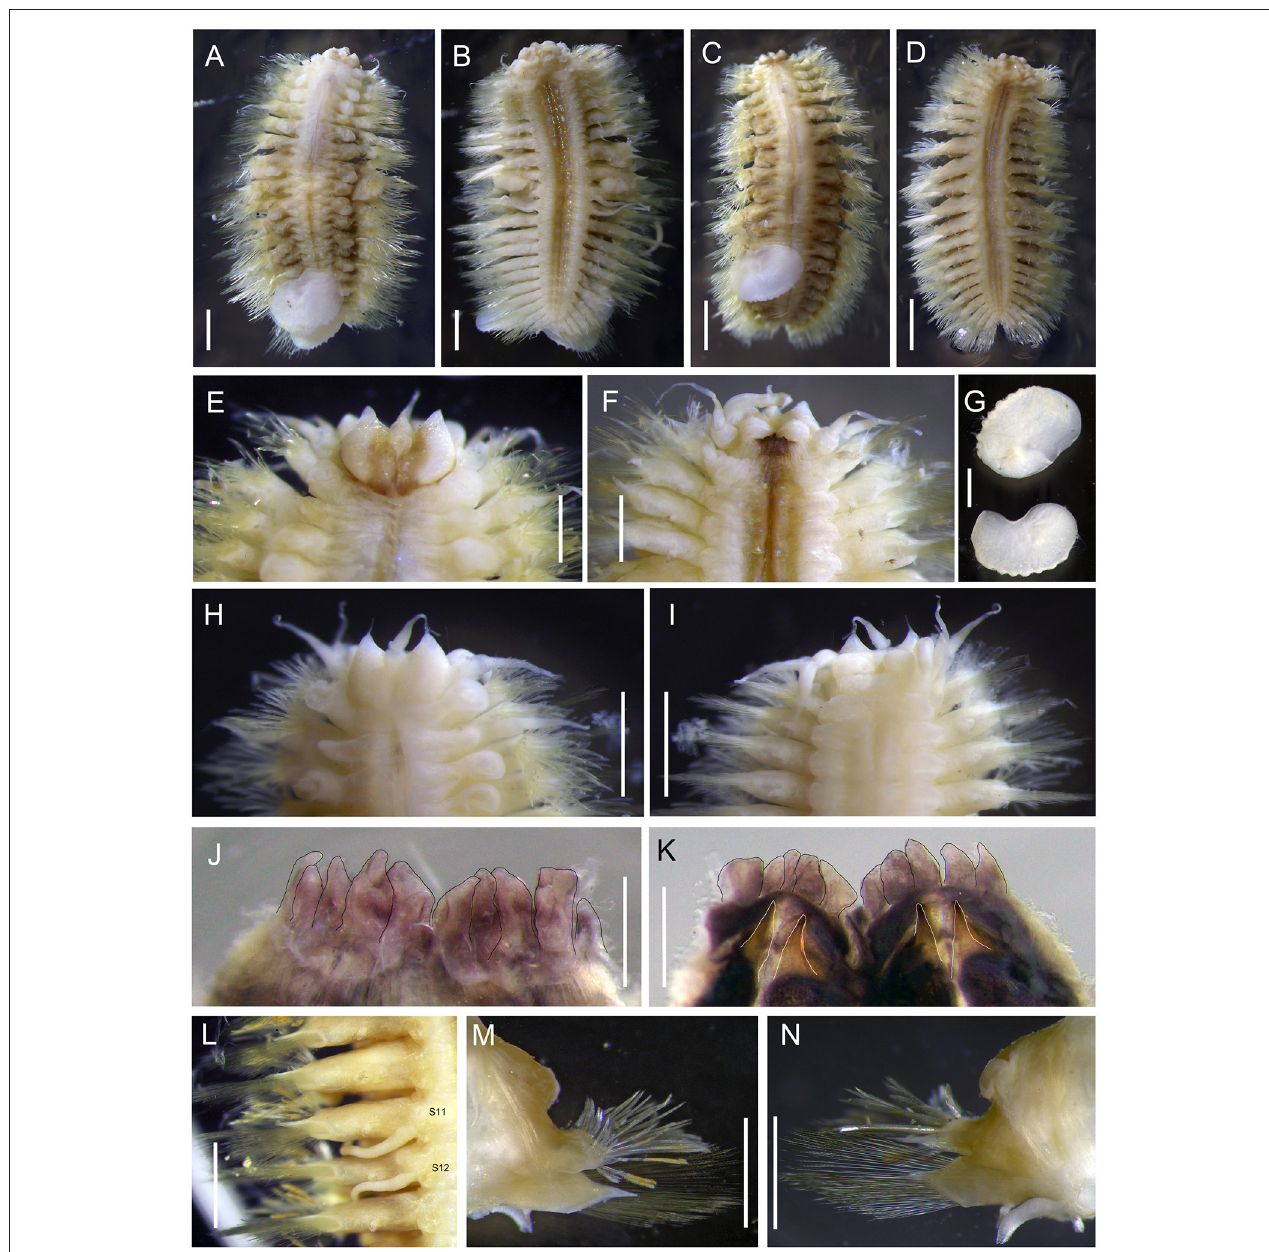
FIGURE 5 | Levensteiniella undomarginata sp. nov. (A,B) specimen: Holotype; (C,D) Paratype 1; (E–G,J–N) Paratype 5; (H,I) Paratype 2. (A) dorsal view of male. (B) ventral view of male. (C) dorsal view of female. (D) ventral view of female. (E) dorsal view of anterior part. (F) ventral view of anterior part. (G) elytra. (H) dorsal view of anterior part. (I) ventral view of anterior part. (J) ventral view of pharynx (cut open) showing some of the terminal papillae (outlined with a black line). (K) dorsal view of pharynx (cut open) showing two pairs of jaws (outlined with a white line). (L) ventral view of segment 11, 12 (male). (M) anterior view of parapodium (segment 11). (N) posterior view of parapodium (segment 11). Scale bar: (A,B,G–I,L–N) 1mm; (C,D) 2mm; (E,F,J,K) 0.5mm.